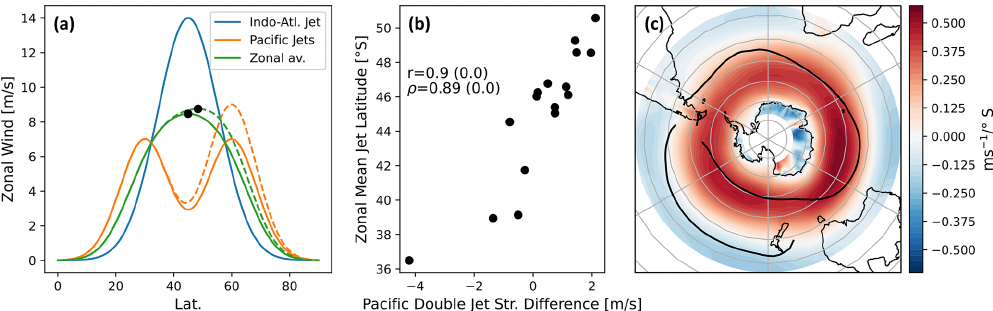
Figure 4. (a) Idealised sketch of the zonal-mean zonal wind structures in the Indo-Atlantic and Pacific sectors and their zonal average. The dashed lines denote a different climatology, while the black dots mark the jet peaks in the two climatologies. (b) The difference in strength between the Pacific double jets plotted against the zonal-mean jet latitude for the 16 CMIP6 models that show two distinct peaks in the Pacific zonal-mean climatology. (c) Inter-model differences in zonal wind climatology regressed onto the inter-model differences in zonal-mean jet latitude. The solid black lines trace the jet positions as in Fig.